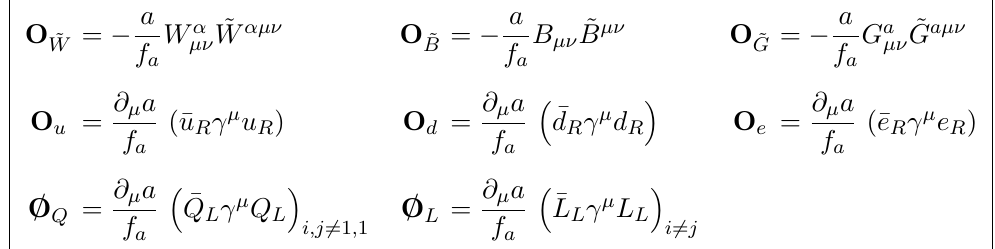
matrix in flavour space, with flavour indices g × n g 4 π O , ˜ X ≡ α X / ˜ X